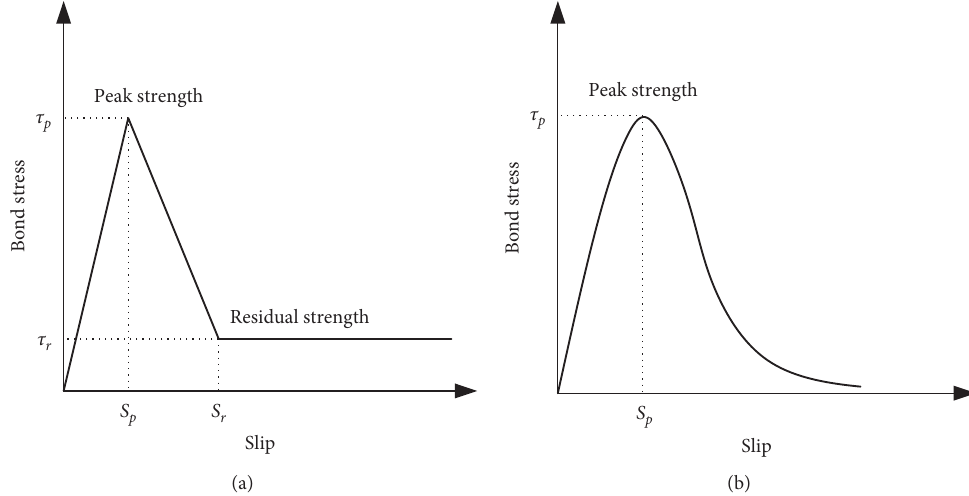
Figure 3: Evolution of the bond-slip model. (a) Trilinear model. (b) Nonlinear